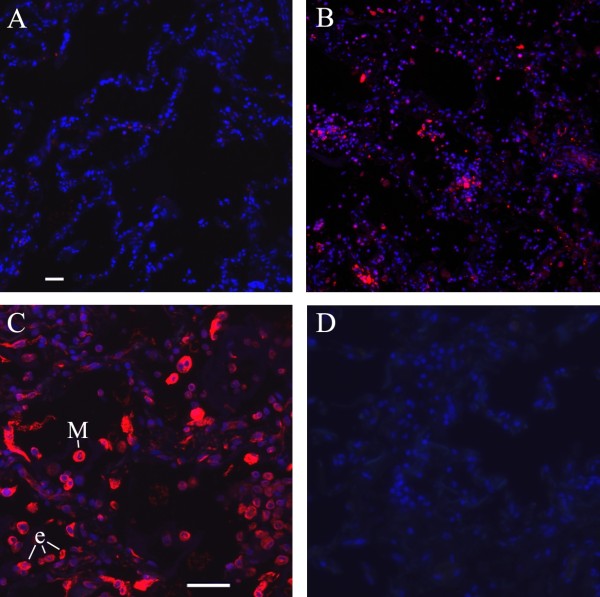
Stromal cell-derived factor 1 in human lung tissue. Tissue sections of normal and SSc-ILD lungs were stained with anti-stromal cell-derived factor 1 (anti-CXCL12) (red) and the nuclear stain DAPI (blue). (A) Normal lung tissue section at × 10 magnification. (B) SSc-ILD lung tissue section at × 10 magnification. (C) SSc-ILD lung tissue section at × 20 magnification. (D) SSc-ILD lung tissue section at × 20 magnification without primary antibody control. Note the massive CXCL12 staining in SSc-ILD lung tissue (B) and (C) and little staining in normal lung tissue (A). e, epithelial cells; M, macrophage. Bars = 10 μm.